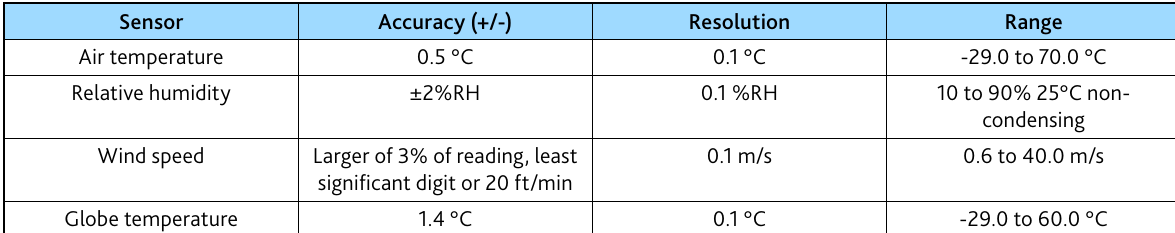
Table 1. Accuracy, resolution and range of Kestrel 5400 Heat Stress Tracker sensors used for human-biometeorological measurements in Banja Luka (Bosnia and